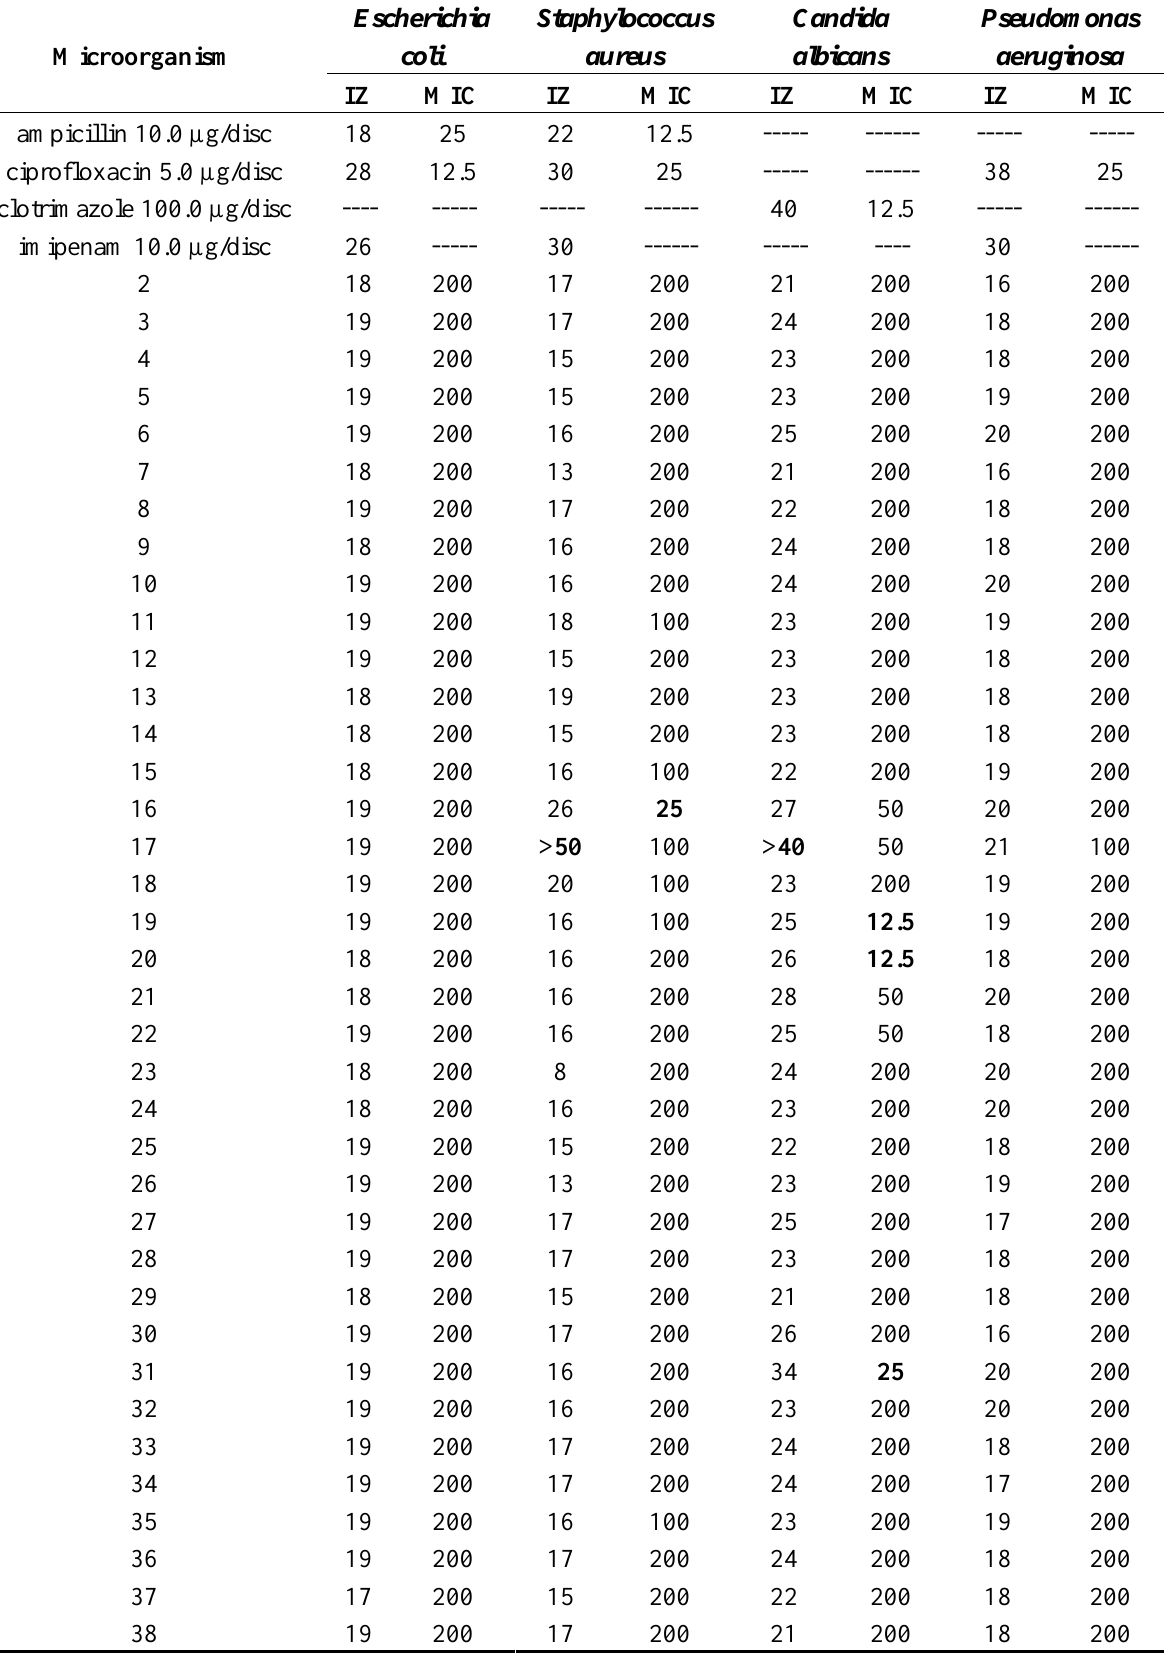
Table 1. In vitro antimicrobial activity of the test compounds and evaluation of the inhibition zone (IZ) and the minim. inhibitory concentration